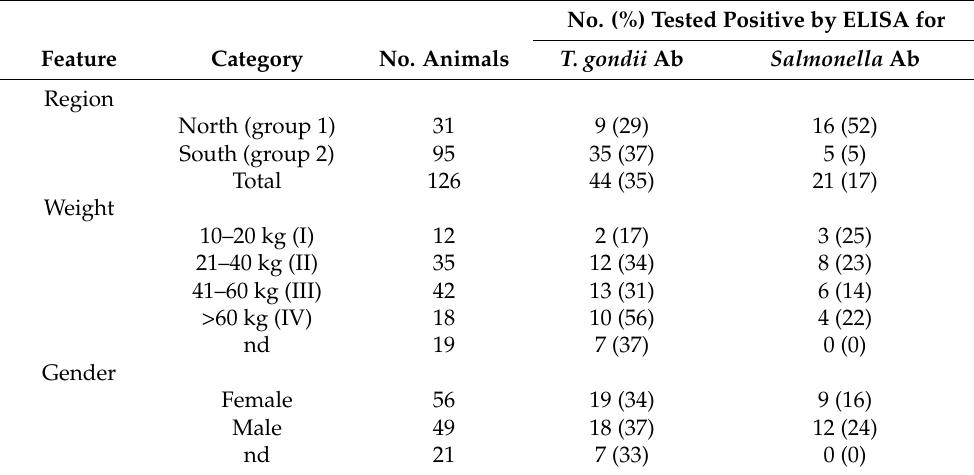
Table 1. Detection rates of Toxoplasma gondii and Salmonella antibodies (Abs) among meat juice samples from 126 wild boars from two different regions in Switzerland, as well as by weight and